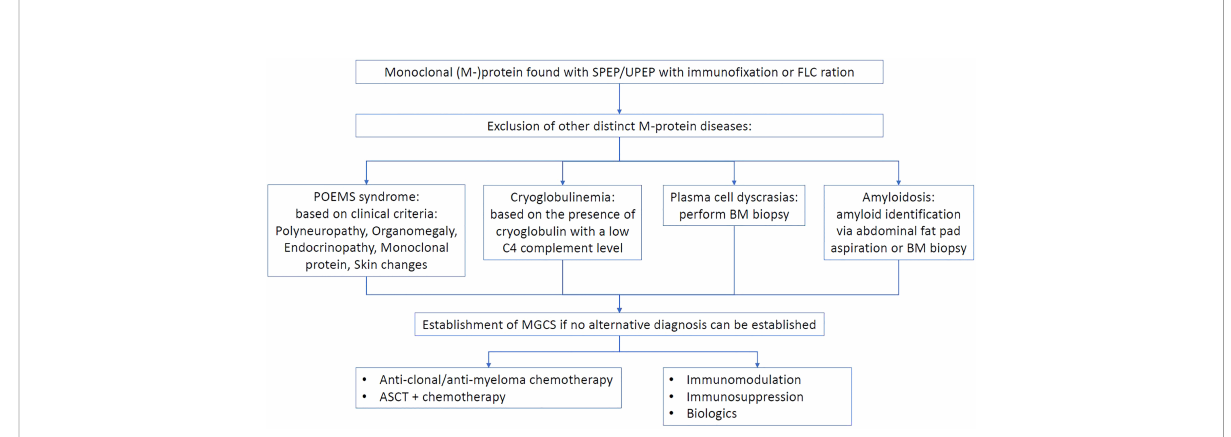
FIGURE 1 Proposed management approach to monoclonal gammopathy of clinical signi fi